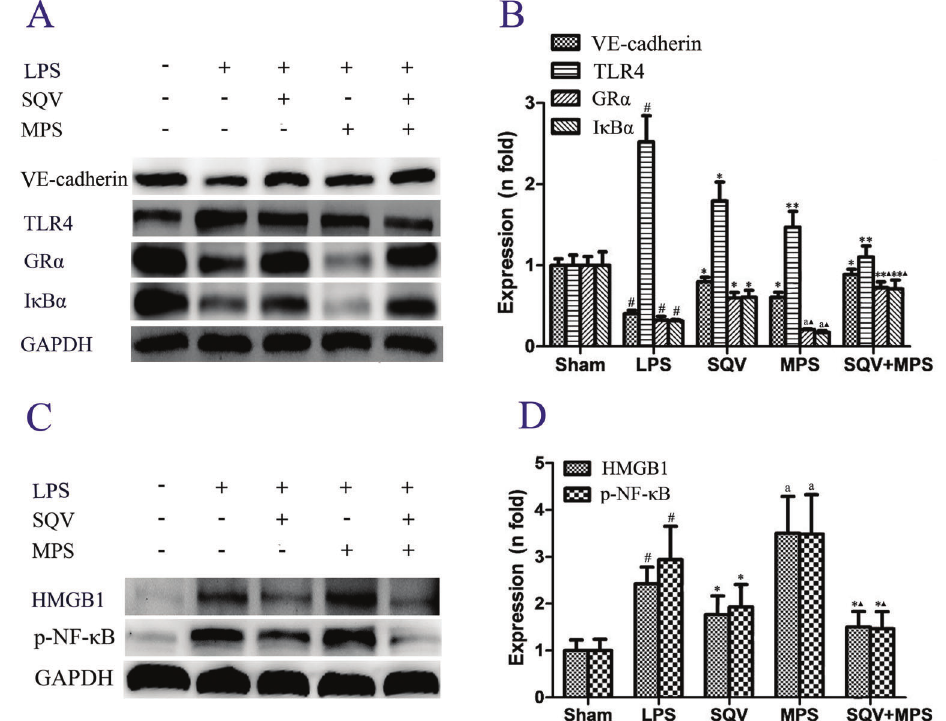
Figure 7. In fl uence of saquinavir (SQV) plus methylprednisolone (MPS) on high mobility group box 1 (HMGB1), toll-like receptor 4 (TLR4), glucocorticoid receptor alpha (GR a ), I k B a , VE-cadherin, and phospho-NF- k B (p-NF- k B) expression in acute lung injury (ALI) rats. LPS, lipopolysaccharide. Data are reported as means ± SD. # P o 0.01 vs the sham group; *P o 0.05, **P o 0.01, a P o 0.05 vs the LPS-treated rats. m P o 0.05 vs the MPS group (ANOVA with Dunnett ’ s